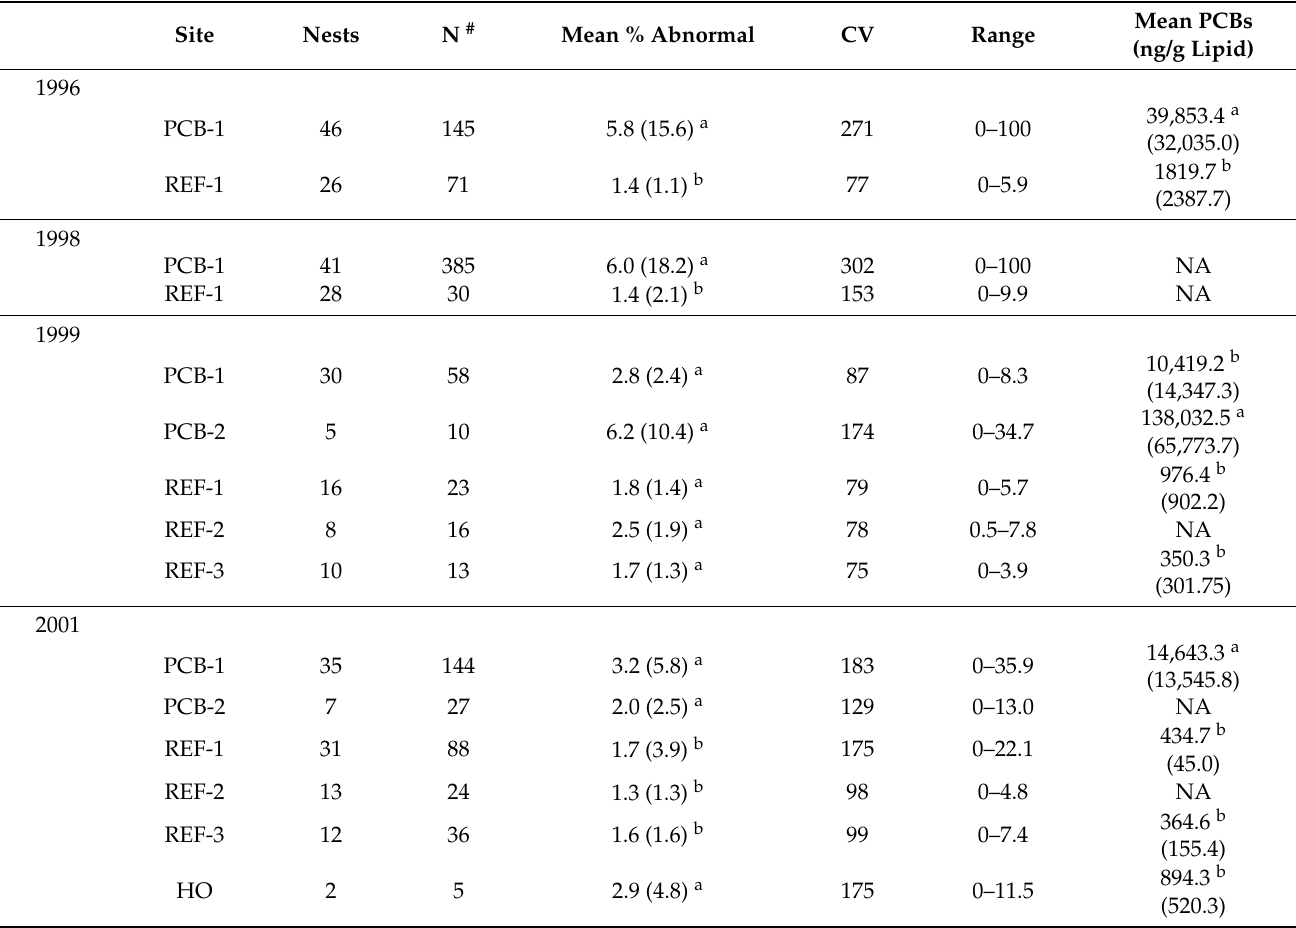
Figure 5. Percent embryo abnormalities occurring at five sites within Johnston Atoll over four years. Note that these are natural log-transformed data. Table 5. Mean (SD) level of abnormalities in damselfish embryos collected in the Johnston Atoll lagoon. Within a year, Mean % abnormal and PCB concentrations with the same superscript letter are not significantly different while sites with different letters are significantly different at p <